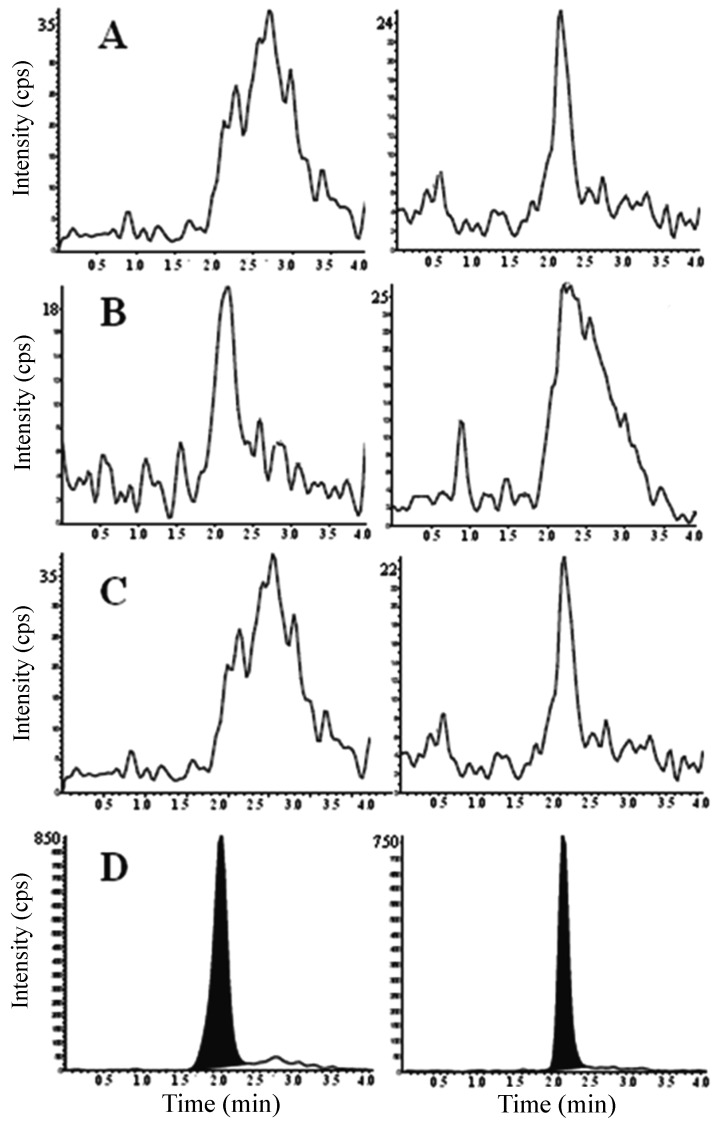
Chromatograms obtained by HPLC-MS/MS for the selectivity study.Negative ion mode: (A) Normal blank serum, (B) lipemic blank serum, (C) hemolyzed blank serum, (D) normal blank serum spiked with IS quercetin (5.0 ng mL−1) and gliotoxin at LLOQ level (10.0 ng ml−1).